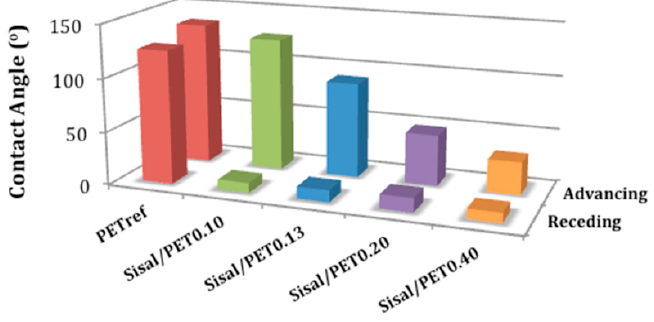
Figure 6. Advancing (errors from ±0.52 (PET ref ) to ±16.31 (Sisal/PET 0.10 )) and receding (errors from ±2.21 (Sisal/PET 0.10 ) to ±7.53 (Sisal/PET 0.13 )) contact angles between the water droplet and the surface of the electrospun